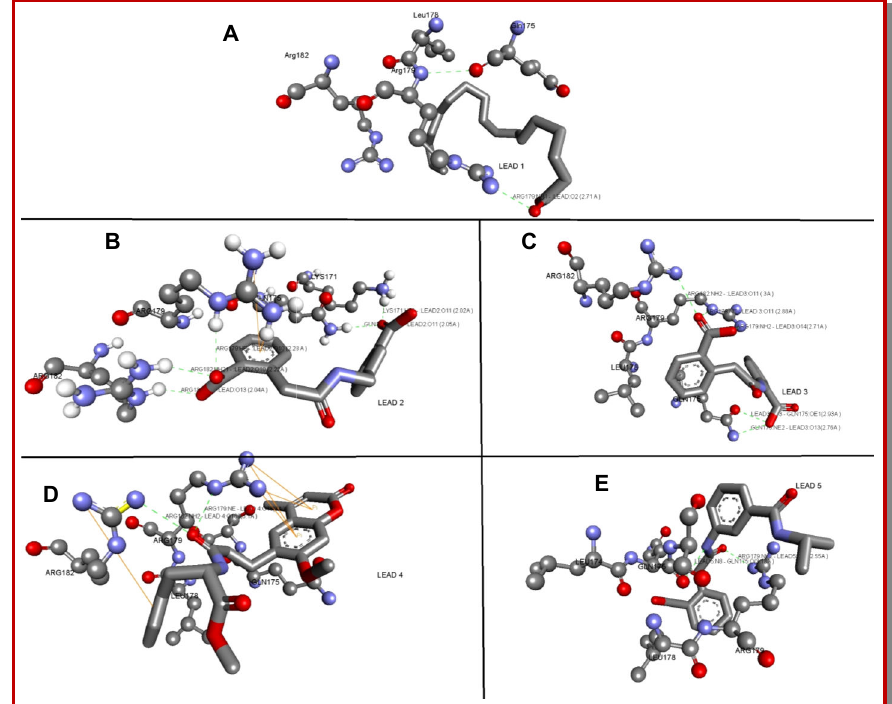
Figure 2: The solid surface structure of Il-6 with lead 5 binding